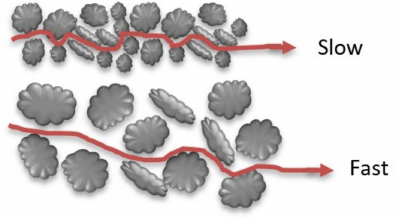
Figure 3. Mechanical dispersion due to pore